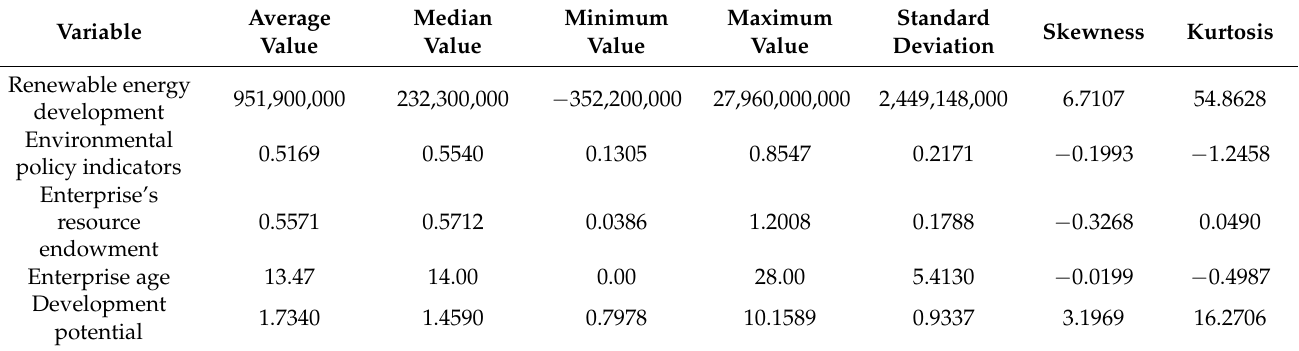
Table 2. Descriptive statistics for each